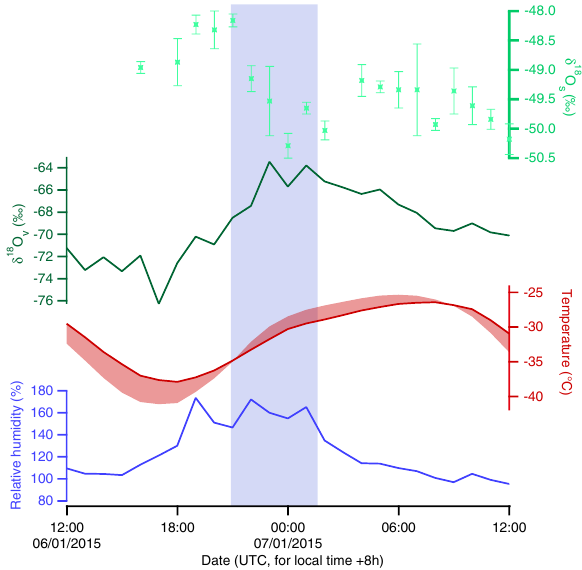
Figure 5. Isotopic composition of surface snow (light green dots, er- ror bars are obtained from triplicates), isotopic composition of wa- ter vapour (dark green line), 3m temperature (red line) compared to the surface temperature (light red shaded area) and relative hu- midity (blue line) during the same period from Casado et al. (2016). The blue vertical bar marks the time period during which frost was formed (see the time-lapse video: